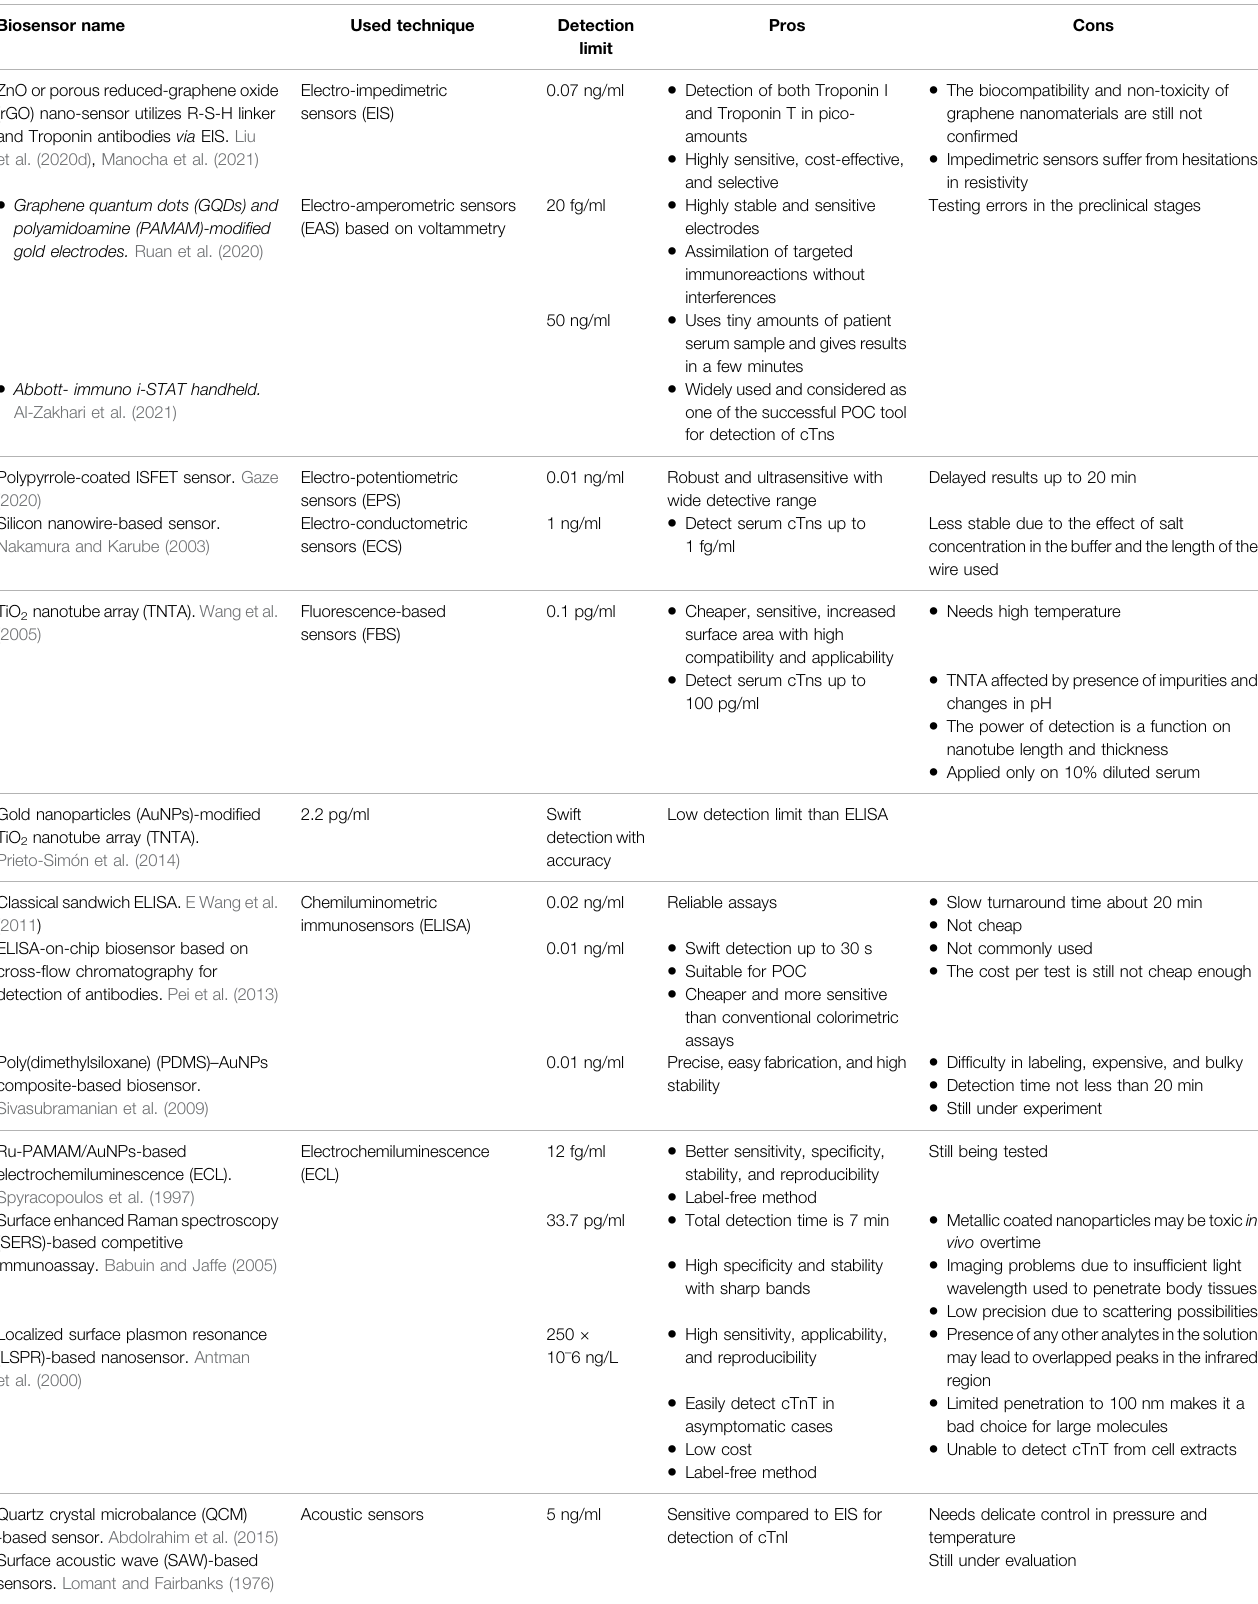
TABLE 3 | A detailed comparison between cardiac tropobiosensors used in lab